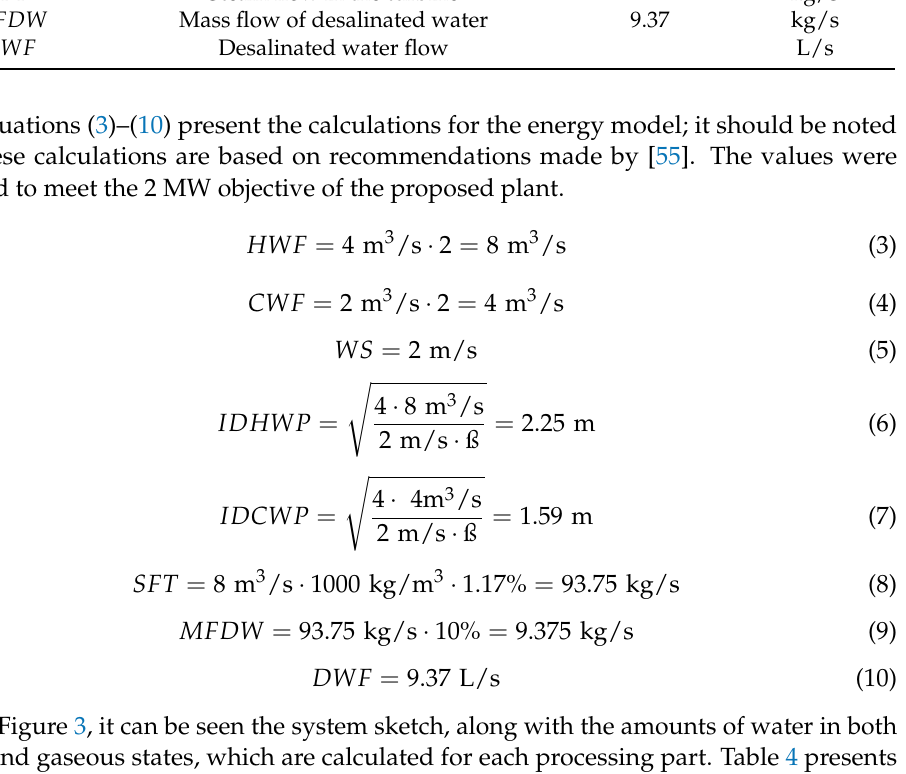
Table 3. Summary of the variables with their respective values calculated for a 2 MW OTEC. Symbol Quantity Values Units HWF Hot water flow 8 m 3 /s CWF Cold water flow 4 m 3 /s WS Water speed m/s IDHWP Internal diameter of hot water pipe 2.25 m IDCWP Internal diameter of cold water pipe 1.59 Steam flow in the turbine Desalinated water flow